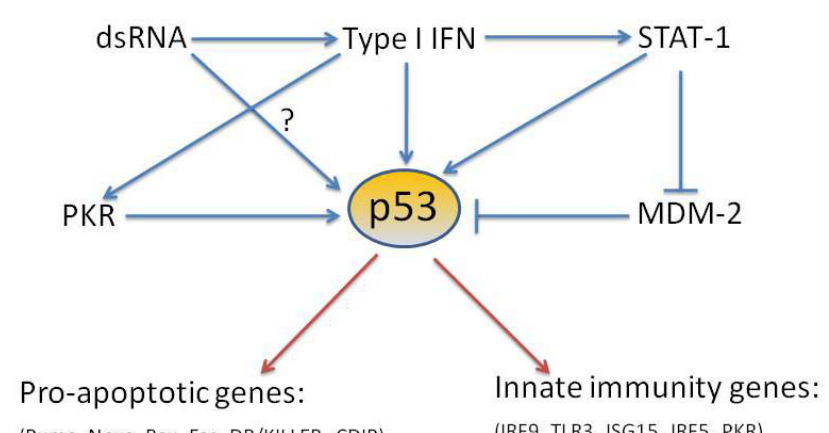
Figure 1. Schematic of the activators and effectors of p53-dependent response in antiviral